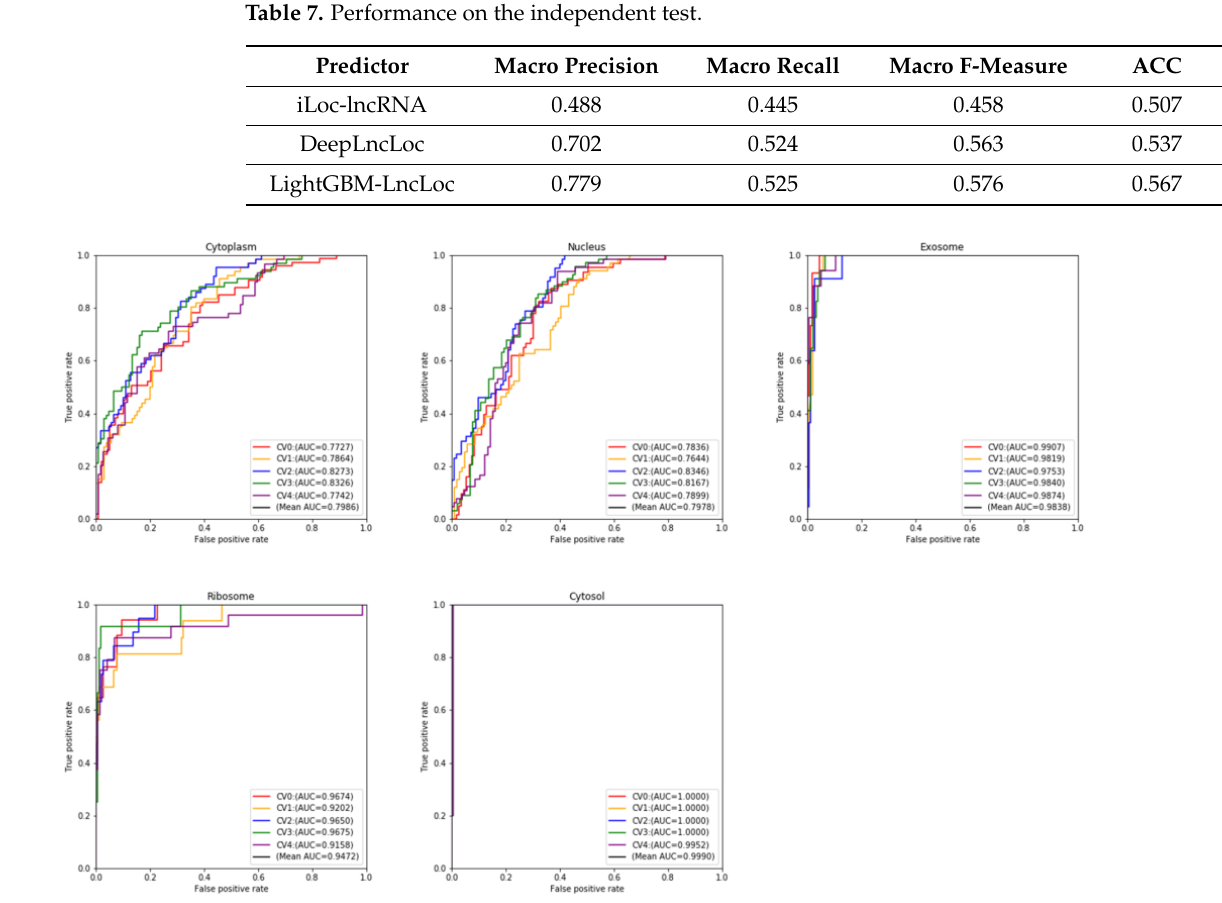
Figure 4. The 5-fold cross-validation ROC curve for each class with LightGBM-LncLoc. Table 8. Performance for each class on the independent Table 6. Performance on 5-fold cross-validation.